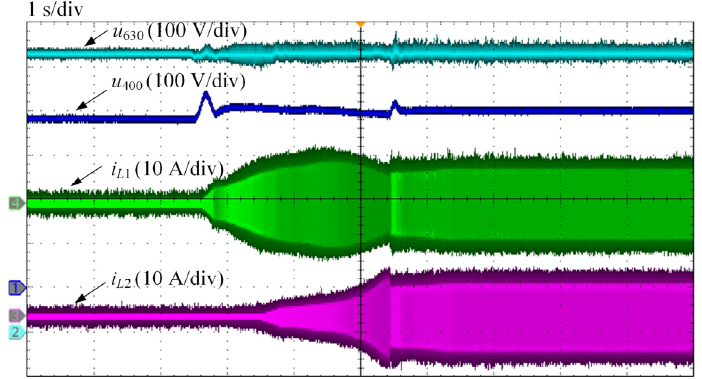
Figure 17. Waveforms of AC load increases from 0 to 7 kW in on-line mode with the original control method. control